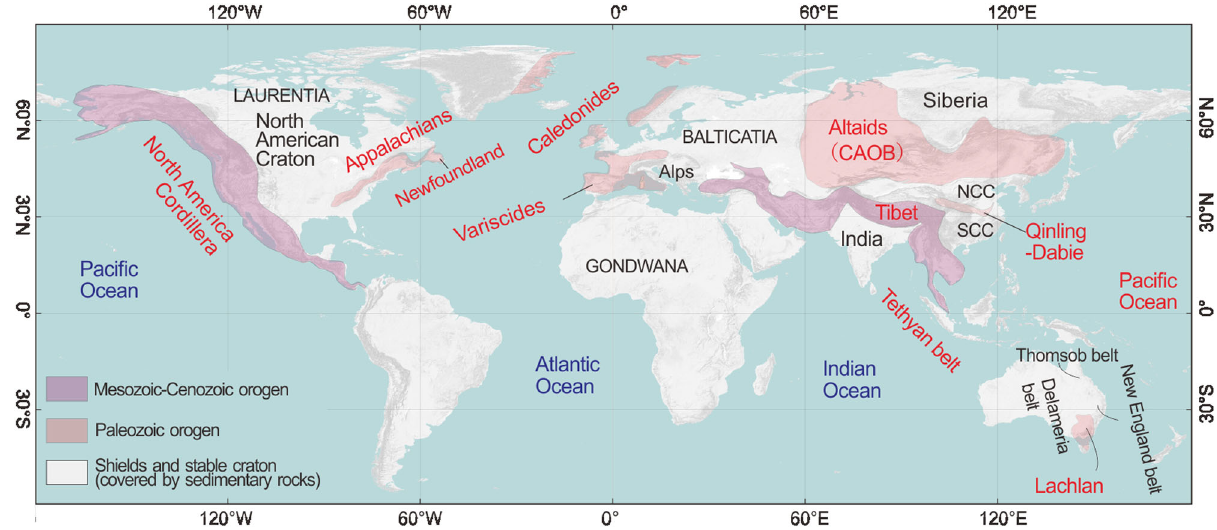
Fig. 1 A map of the eight representative and well-studied orogens in the world, showing their locations and tectonic background. NCC North China Craton; SCC South China Craton. The digit topographic map comes from